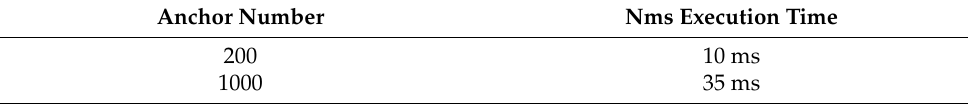
Table 1. The relationship between anchor numbers and latency from Reference article [4]. Anchor Number